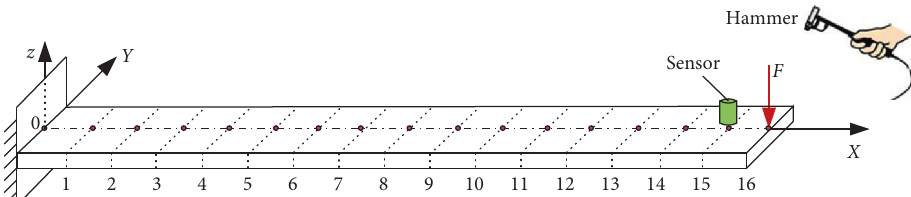
Figure 2: Numerical simulation model of the cantilever